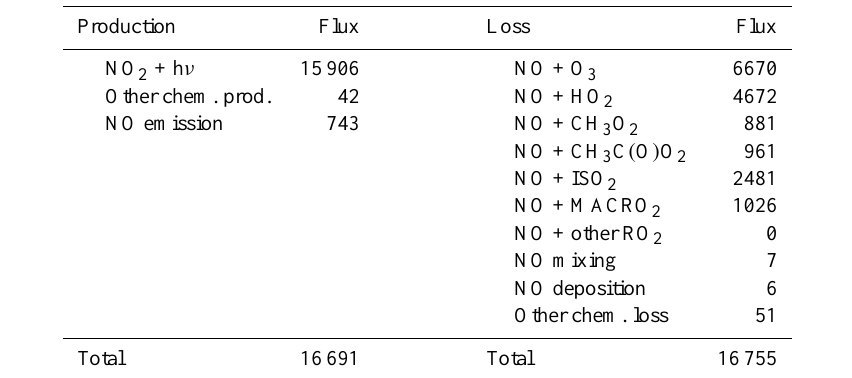
Table 4. Budget statistics for integrated NO in [pptv day − 1